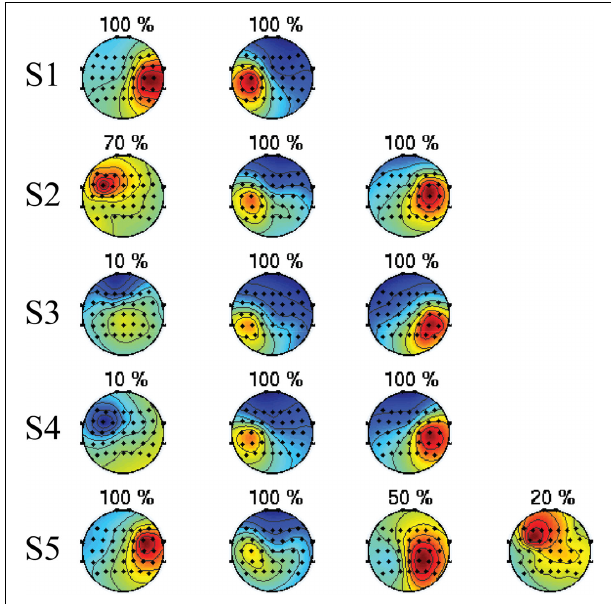
FIGURE 5 | Topographies of the automatically selected ICA components. Each row represents one subject, and each topographic map represents a cluster of ICA components obtained by hierarchical clustering along cross-validation folds. On top of each map there is the selection ratio r representing how frequently a member of the cluster is selected along folds. Spatial filters with a selection ratio r ≥ 50% represent, for every subject, either the activation of the left or right hemisphere. Moreover, it is important to note that the selected spatial filters cover areas of the EEG electrode space that are different from subject to